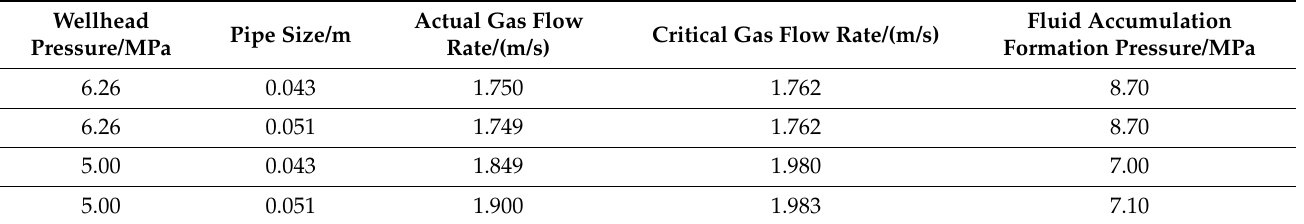
Table 3. Formation pressure at which fluid began to accumulate at different wellhead pressures for different pipe diameters.